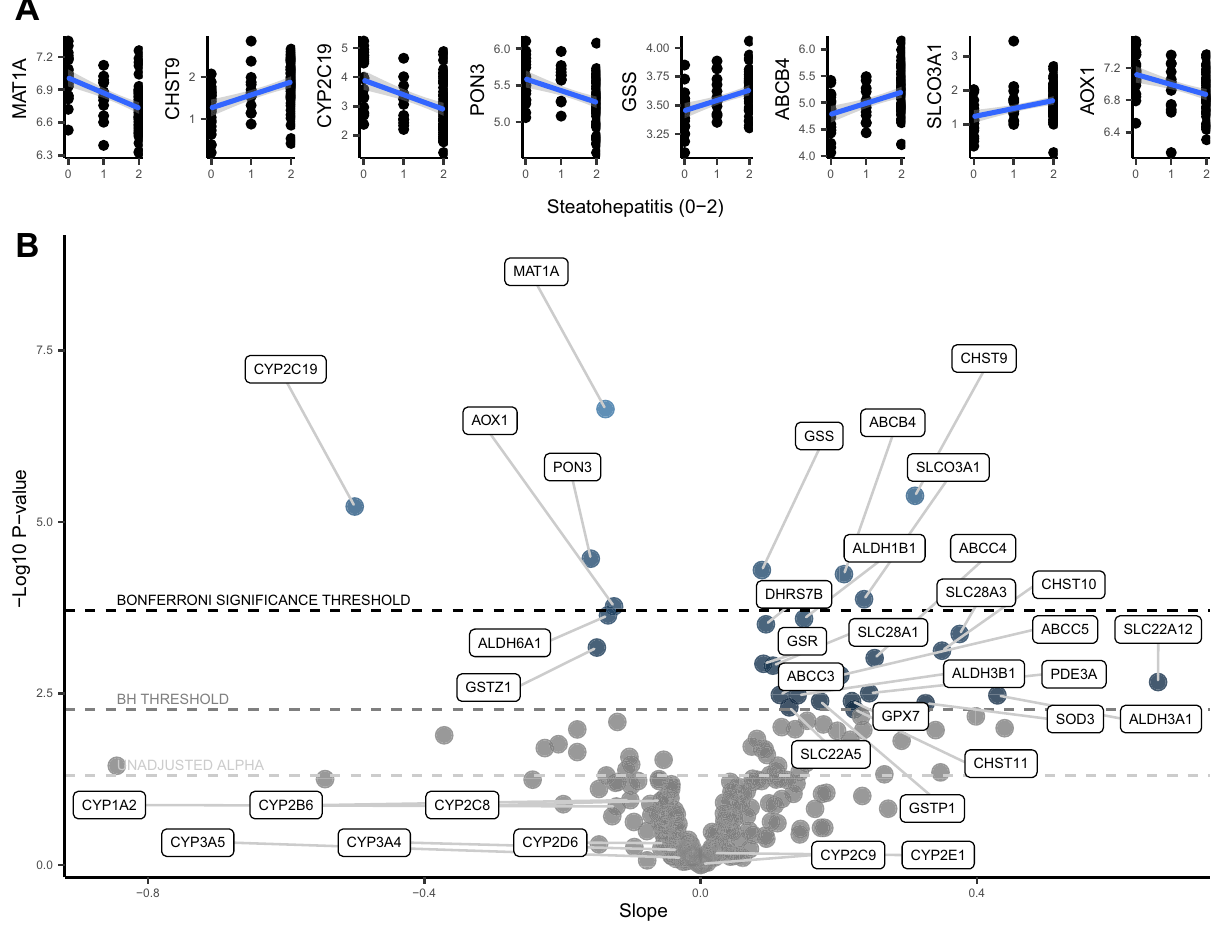
expression. Horizontal dotted lines correspond to the Bonferroni signi fi cance threshold,BenjaminiHochberg(BH)signi fi cancethreshold,anduncorrectedalpha of 0.05, from top to bottom, respectively. Source data are provided in the sup- plemental